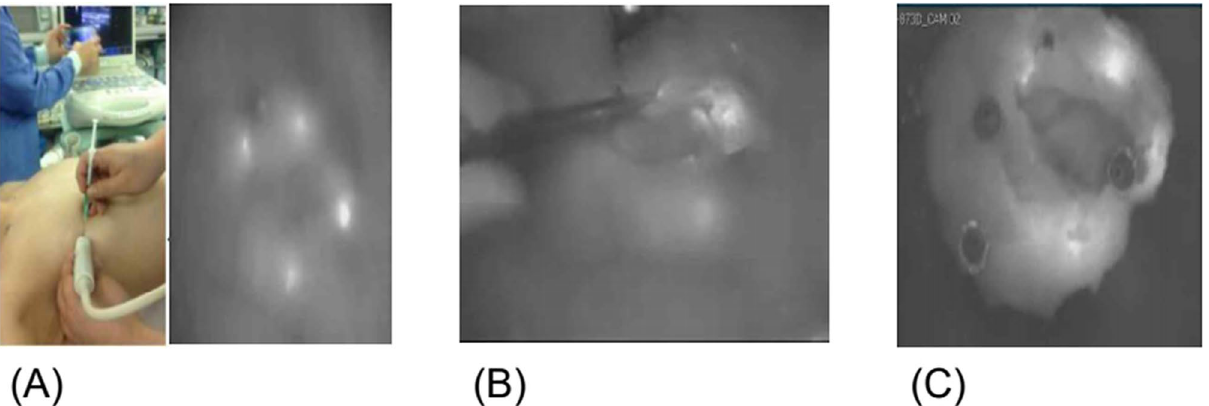
Figure 2. Localization by ICG injection (ICG injection into the target lesion under the guidance of ultrasonography). ( A ) The fluorescent agent is injected into 4–8 areas of the breast cancer resection surface using ultrasound before surgery. ( B ) During surgery, the surgeon finds and removes the fluorescent lesion using a near-infrared fluorescence camera. ( C ) After lesion removal, the completeness of the resection through a near- infrared fluorescent camera was confirmed.